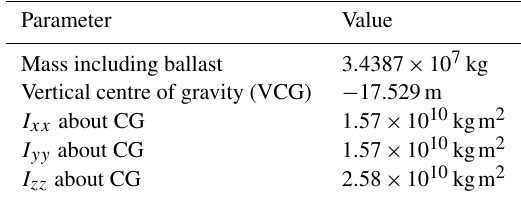
Table 5. Activefloat substructure parameters.